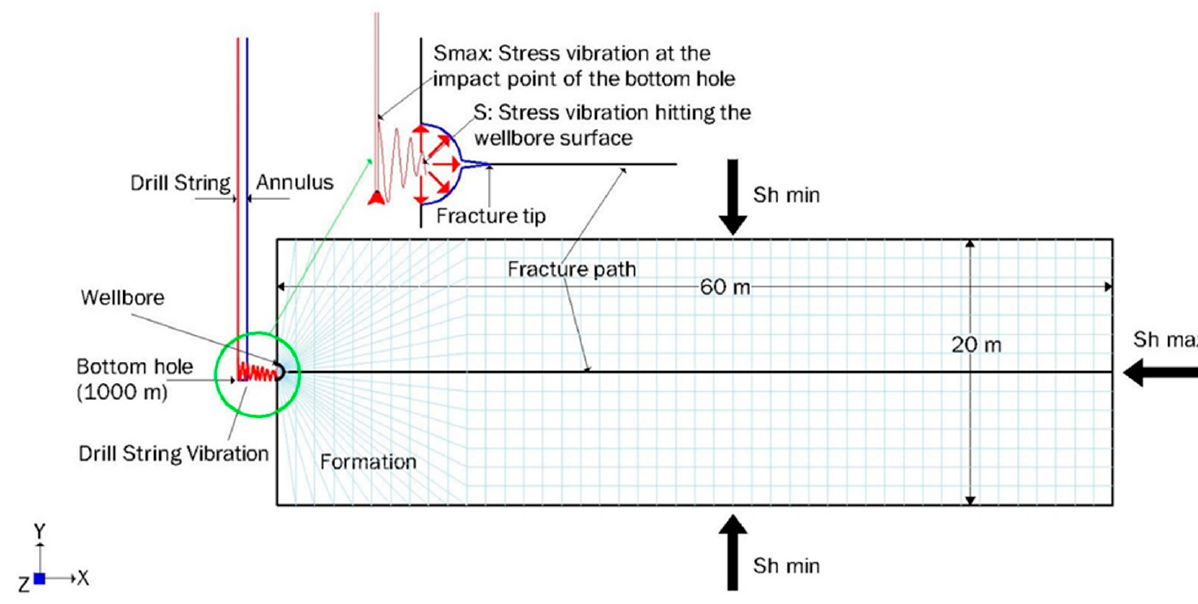
Figure 4. Schematic of the numerical model redrawn from [17]. Sh max and Sh min respectively represent the maximal and minimal horizontal stresses. The drill string and the wellbore annulus are in the vertical Z direction, but they are represented in the Y direction for better visualization. The natural fracture opens in the horizontal X - Y plane. The formation is in plane strain condition in the horizontal X - Y plane.